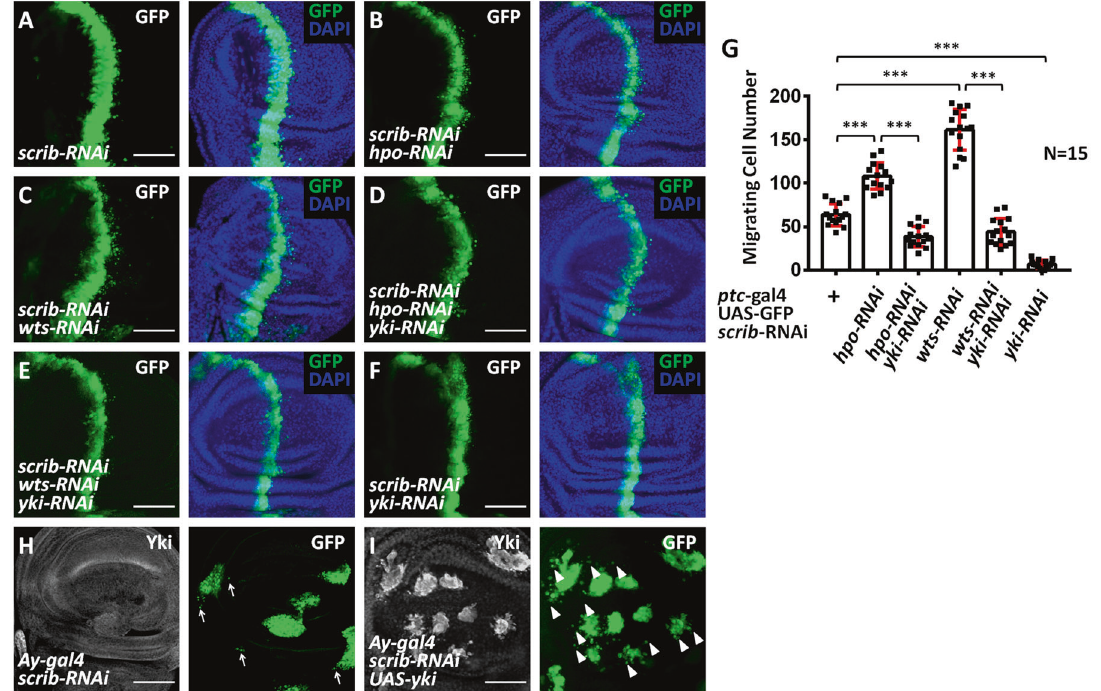
Fig. 1 Inhibition of the Hippo pathway promotes tumor cell migration through Yki. A Knockdown of scrib in the wing disc triggered cell migration from A/P boundary to posterior. GFP (green) marks the expression pattern of ptc-gal4 driver. B Knockdown of hpo increased scrib - RNAi-induced cell migration. C Silence of wts elevated scrib -RNAi-induced cell migration. D A wing disc expressing hpo RNAi plus yki RNAi simultaneously under scrib RNAi background were stained with GFP (green) and DAPI (blue). Knockdown of yki attenuated hpo -RNAi- enhanced cell migration. E Knockdown of yki attenuated wts -RNAi-enhanced tumor cell migration. F Knockdown of yki effectively blocked scrib -RNAi-induced cell migration. G Quanti fi cation of migrating cell numbers in A - F ( N = 15). Data are presented as means ± SD of values from fi fteen wing disks. H A wing disc expressing scrib RNAi by Ay-gal4 was stained to show Yki (white) and GFP (green). Knockdown of scrib triggered moderate cell migration (arrows). I A wing disc simultaneously expressing scrib RNAi and yki induced apparent cell migration (arrowheads). Scale bars: 50 μ m for all